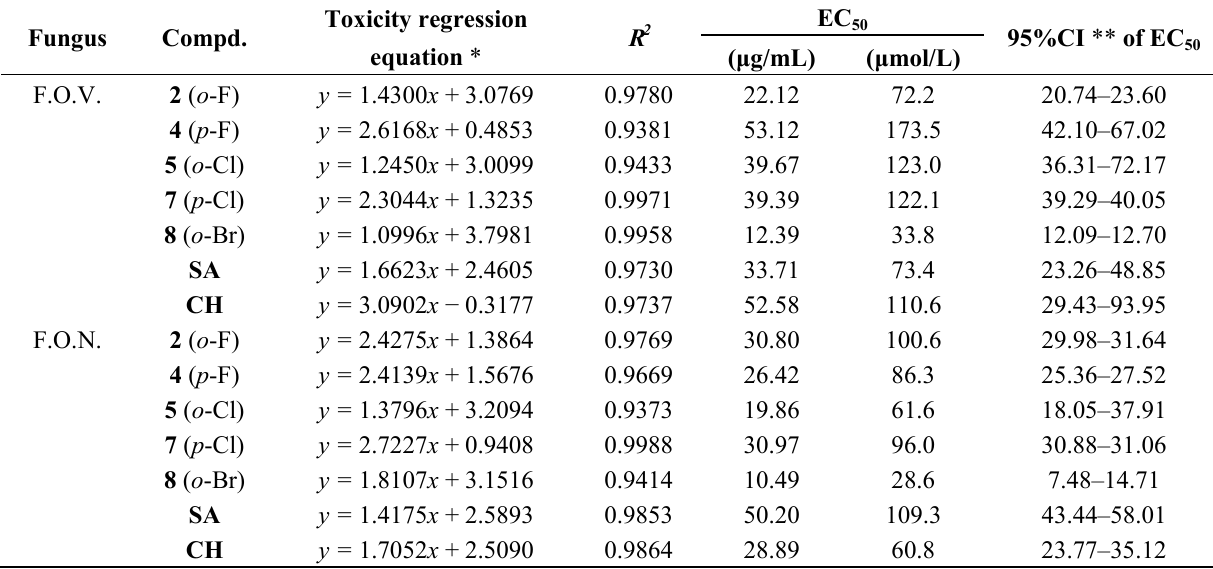
values of 2 , 4 , 5 , 7 and 8 against 7 fungi. 50